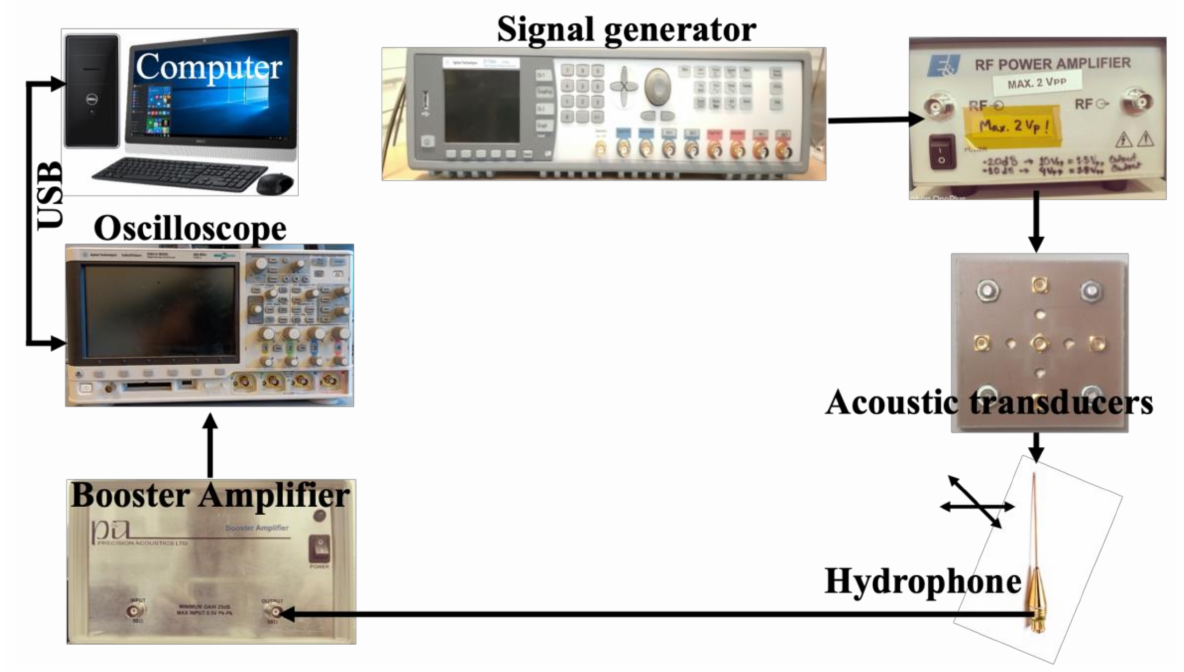
Figure 6. An experimental setup for the hydrophone system for the focal length